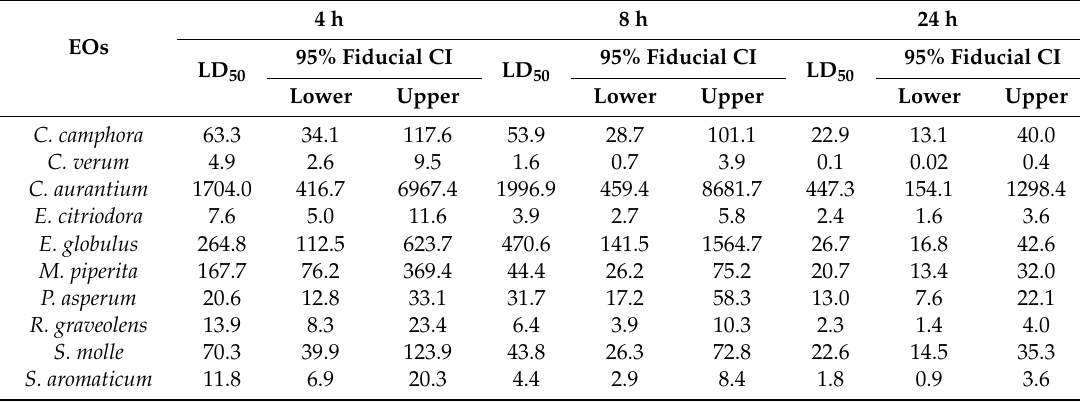
Table 2. LD 50 values of the ten tested EOs at 4, 8 and 24 h exposures of M. incognita J2 . 4 h 8 h EOs LD 50 Lower Upper Lower Upper Lower